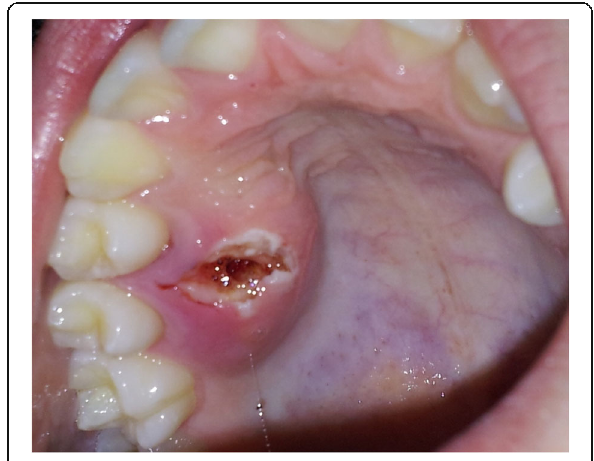
Fig. 2 Palatal swelling (post-biopsy) between upper right first and second premolar